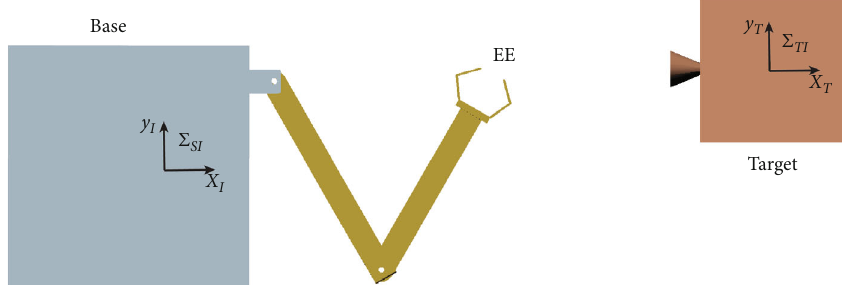
Figure 4: Simulation model of the planar dual-link space robot in the initial con fi